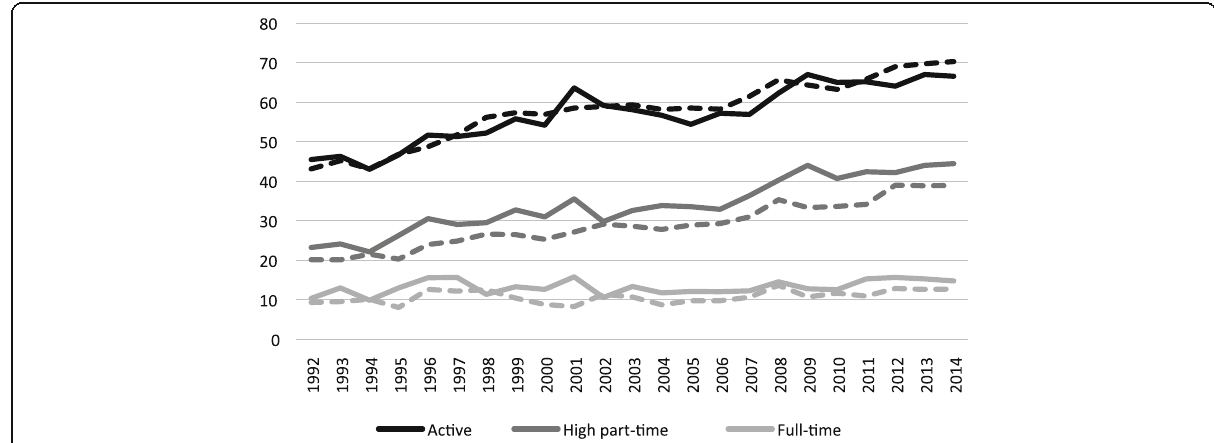
Fig. 2 Change of several dependent variables on maternal employment over time depending on the canton of residence. Source: Swiss Labour Force Survey 1992 – 2014. The dotted lines indicate control cantons and full lines treated